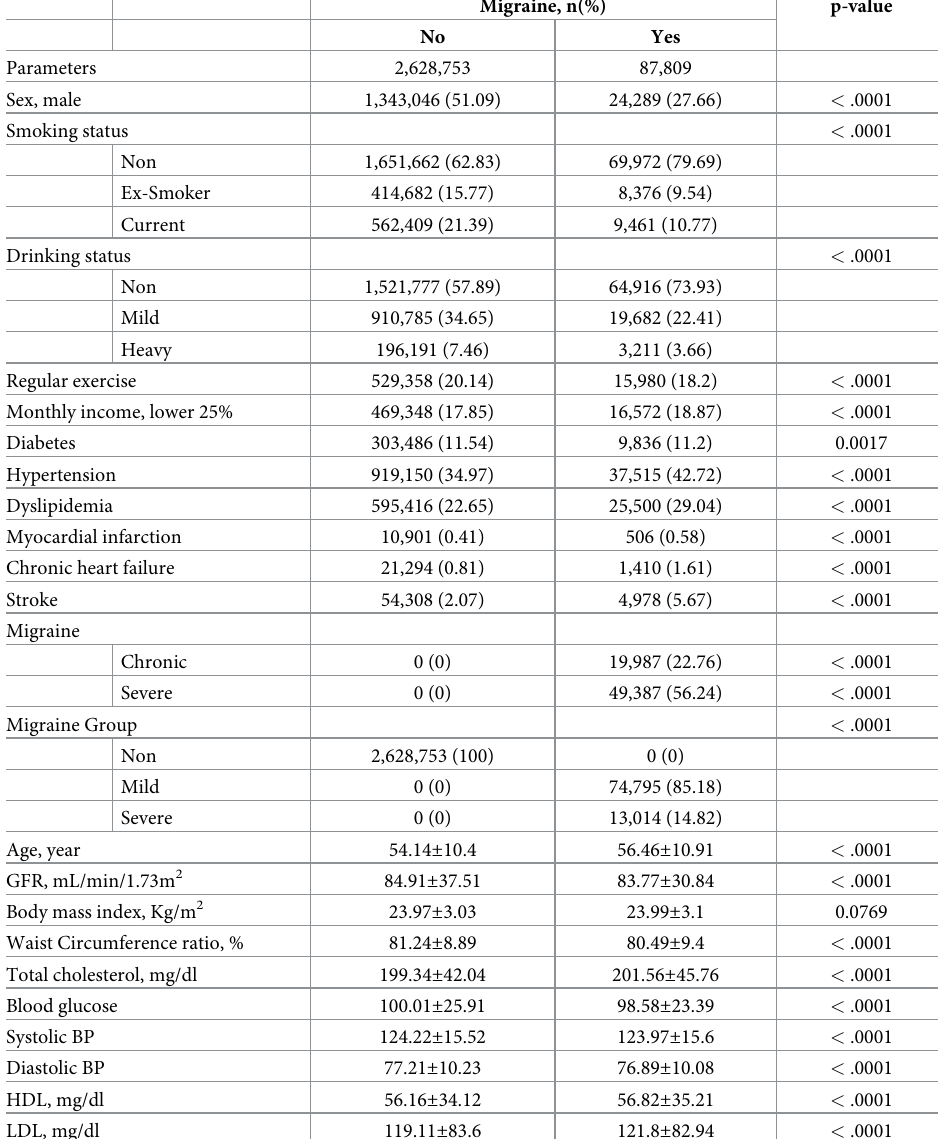
Table 1. Demographic characteristics of study